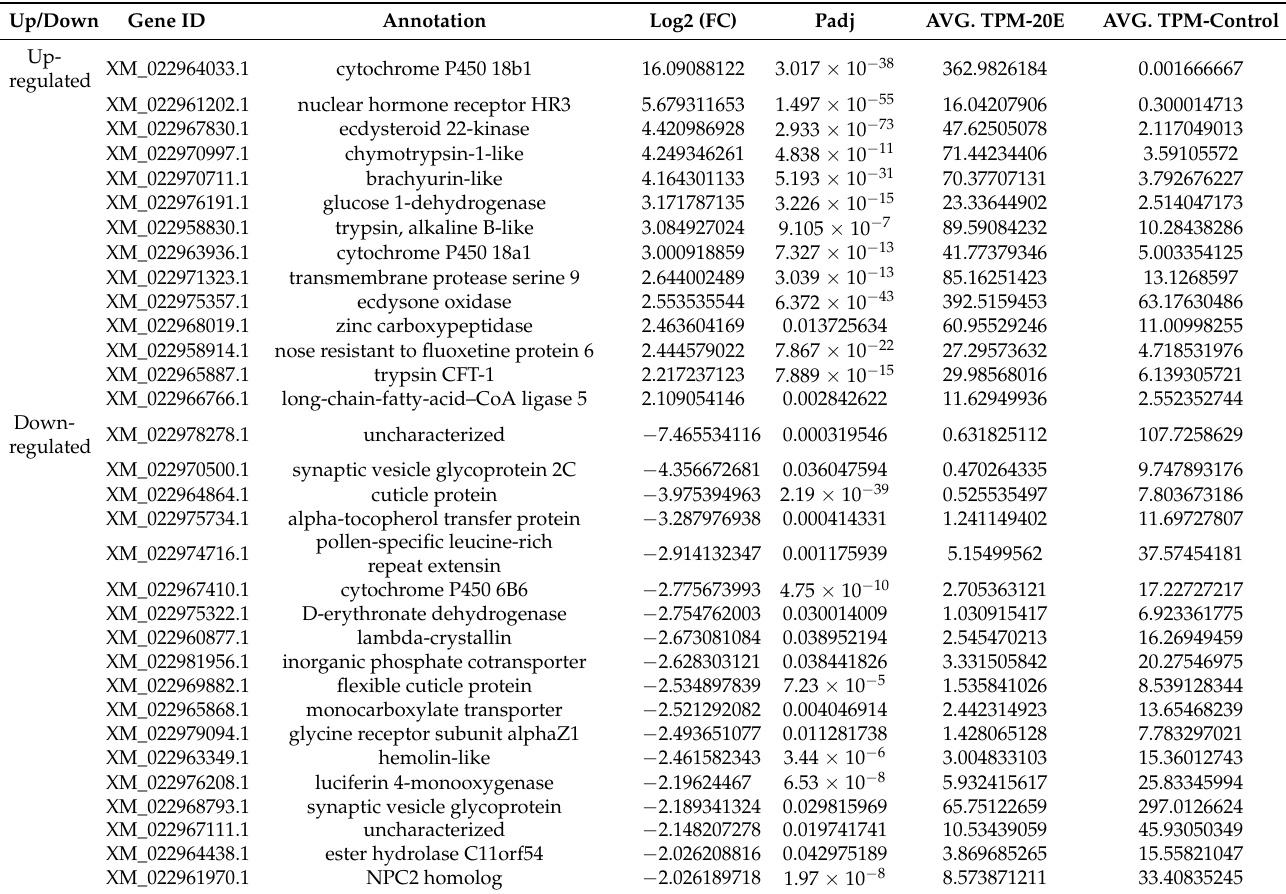
Table 3. The dramatically changed genes in the gut of S. litura